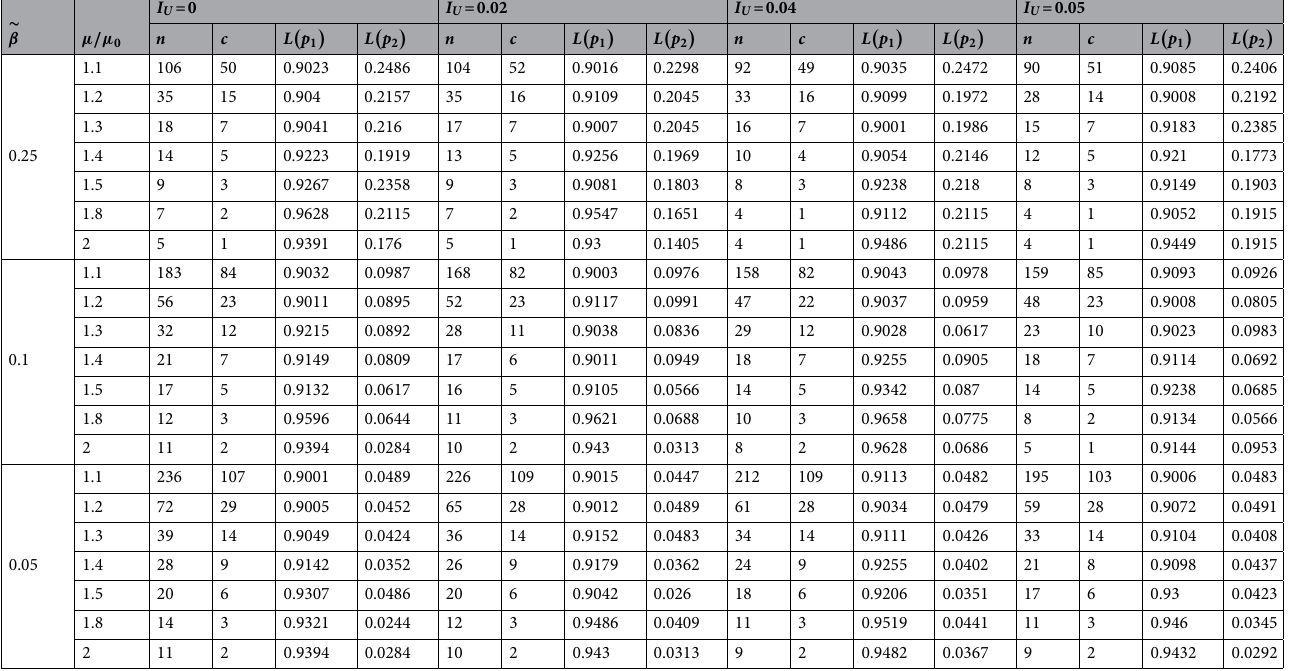
∼ α = 0.10 ; β = 3 and a = 0.10 .